Question: Express in one sentence what the figure is showing.
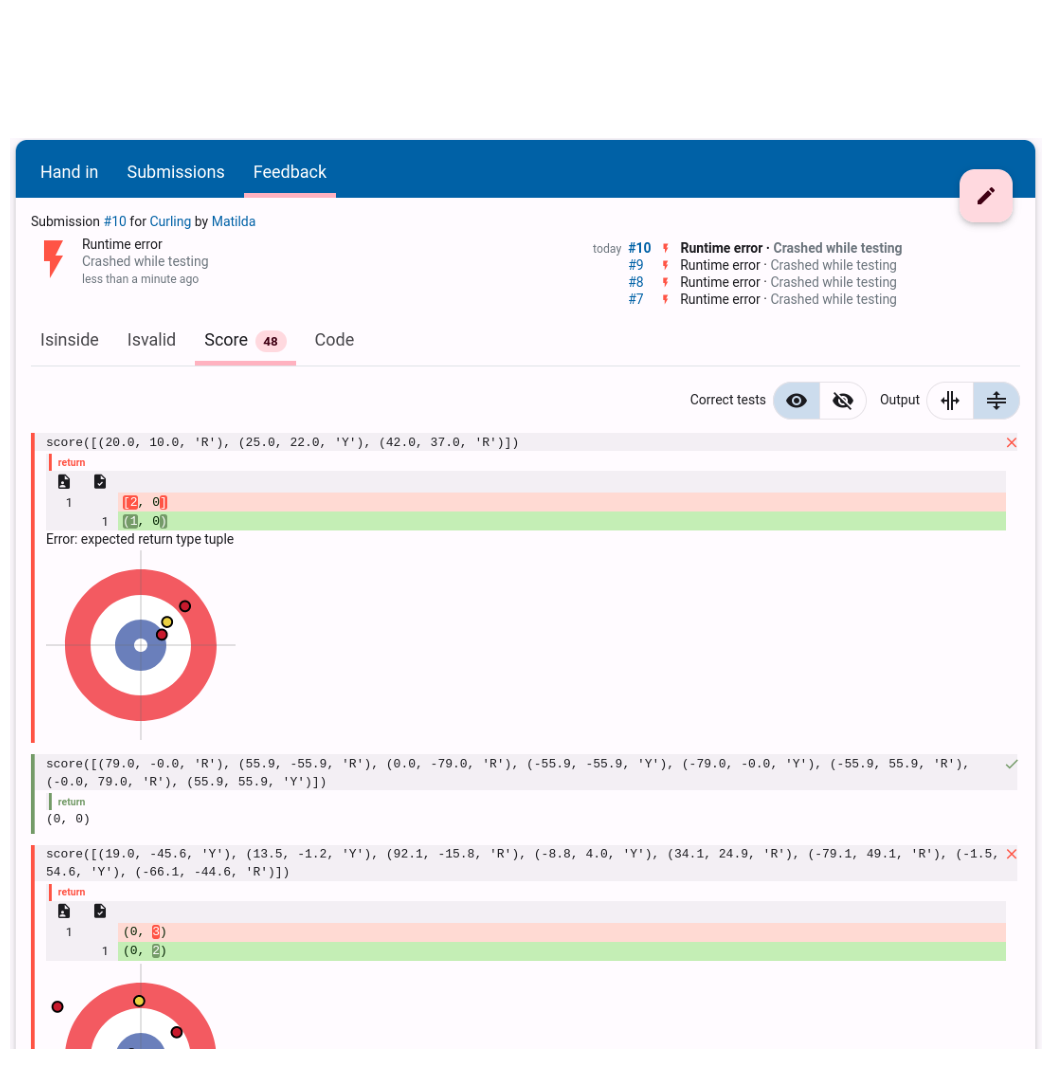
Answer: Dodona rendering of feedback generated by the judge that assessed a submission of the Python programming assignment “Curling”4. The judge split its feedback across three tabs, one for each function that needs to be implemented for this assignment: isinside, isvalid and score. All tests under the isinside and isvalid tabs passed, but 48 tests under the score tab failed as can be seen immediately from the badge in the tab header. Dodona also added a fourth tab “Code” that displays the source code of the submission with annotations added during automatic and/or manual assessment (Figure 7). Green/red vertical lines on the left reﬂect the grouping of test cases into execution contexts (here each execution context contains a single test case). Dodona automatically highlighted the diﬀer- ences between the generated and expected return values of the ﬁrst and third (failed) test case and the judge used unstructured HTML snippets to add a graphical representation (SVG) of the curling